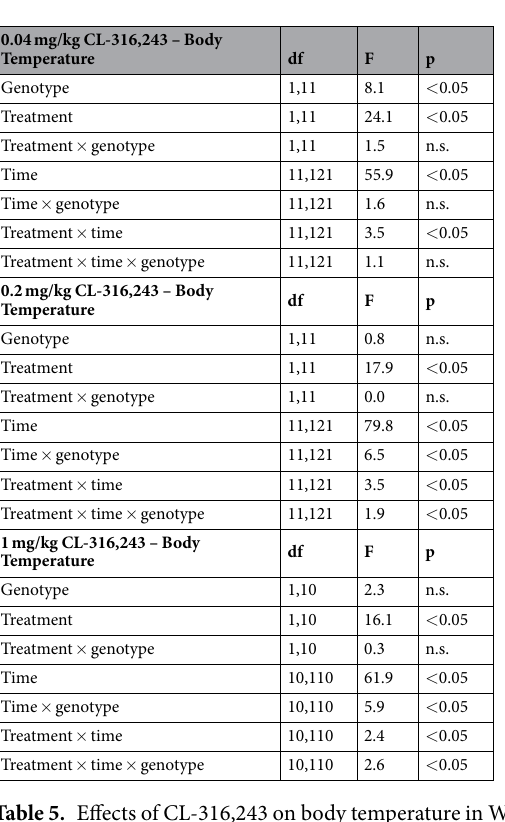
Table 5. Effects of CL-316,243 on body temperature in WT and UCP-1 KO mice – statistical results.